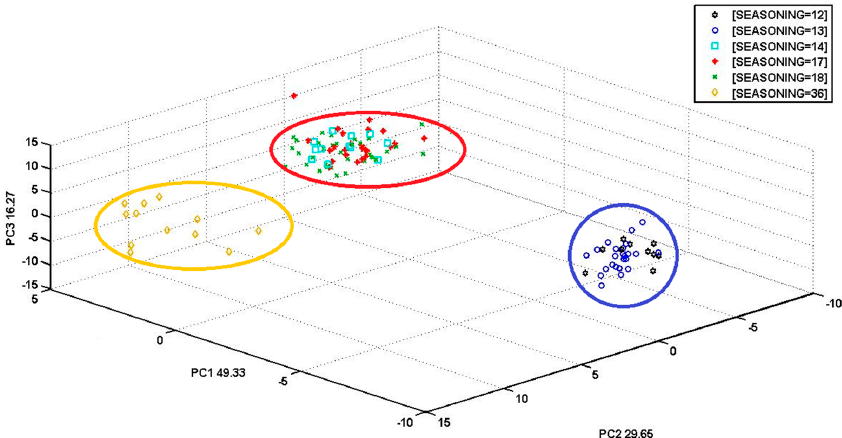
Figure 6. This is a PCA score plot from S3 measurements related to the sensor array response to the volatiles of cheese samples with different ripening times (in months), shown inside the clusters represented by red, blue, and yellow colors. The samples with 12 and 13 months of ripening are cluster. Explained variance: PC1 = 49.33%, PC2 = 29.65%, PC3 = 16.27%. grouped within the blue cluster; the samples with 14, 17, and 18 months of ripening are grouped within the red cluster; and the samples with 36 months of ripening are grouped within the yellow cluster. cluster. Explained variance: PC1 = 49.33%, PC2 = 29.65%, PC3 = 16.27%. Explained variance: PC1 = 49.33%, PC2 = 29.65%, PC3 =